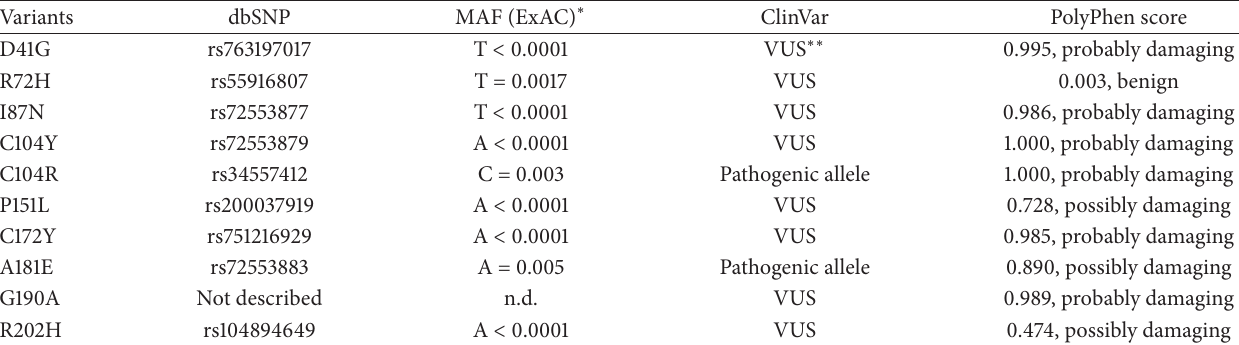
Table 2: Summary of the nonsynonymous variants identified in patients with CVID and